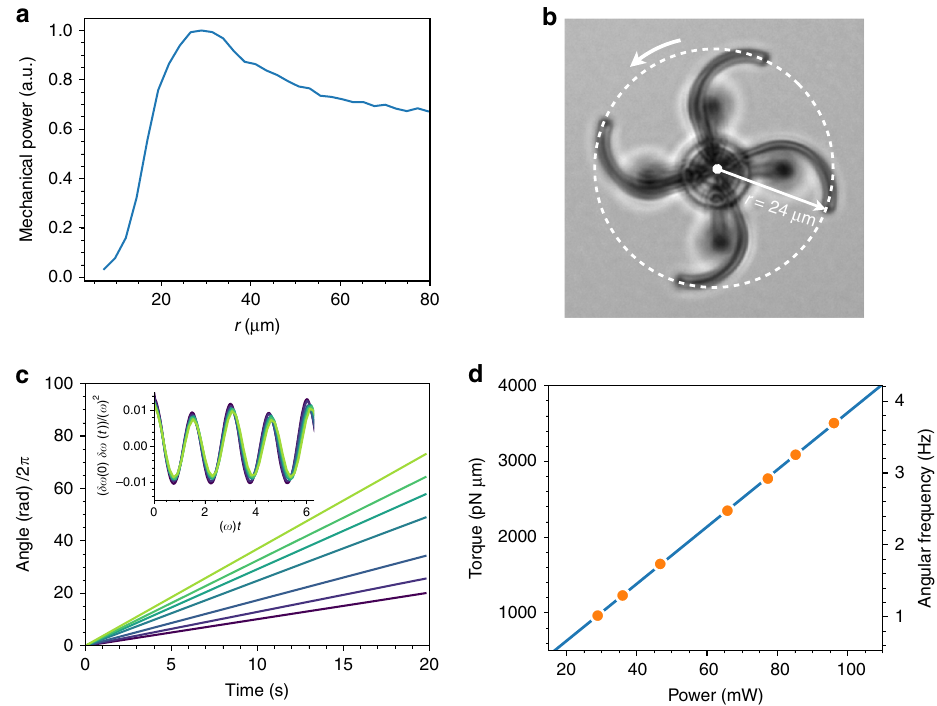
Fig. 3 Rotating microturbines. a Expected mechanical power as a function of the structure radius. b Optical microscopy image of a rotating structure. c Time evolution of the angular position of a rotating structure driven by different laser powers. Inset shows the time autocorrelation function of the relative fl uctuations of the angular speed. d Torque and angular frequency as a function of laser power. Laser power has been measured on the objective focal plane with a microscope slide power sensor (Thorlabs S170C). Solid line is a linear fi